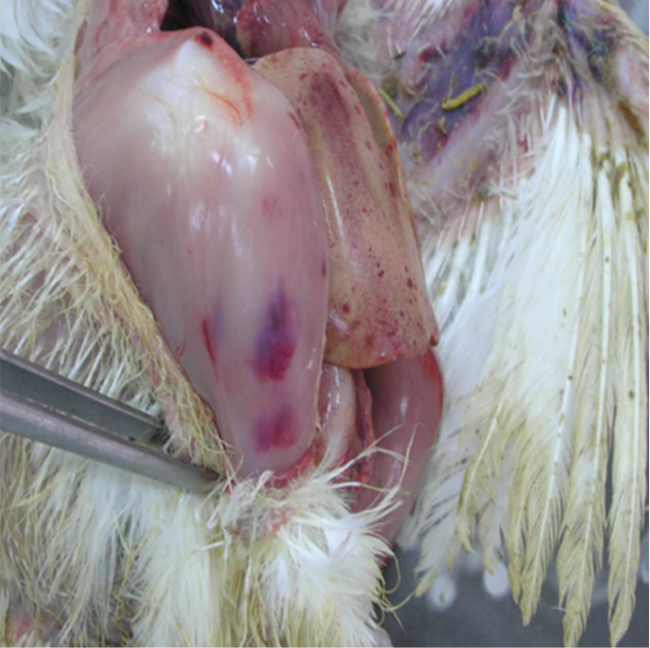
Figure 4. Gross-pathology findings on a 23-day-old broiler chicken, which was submitted for post- mortem examination in the Unit of Avian Medicine, Thessaloniki, Greece during the IBH outbreak. The presence of hemorrhages on the skeletal muscles of the bird is visible, whereas, the liver domi- nates in the visceral capacity with the lobes of the organ appearing swollen with a marble-like pattern ranging from pale and yellowish to